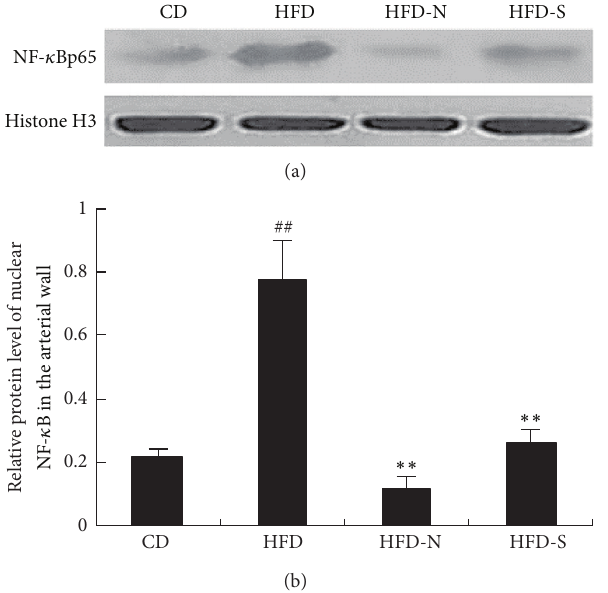
Figure 2: Niacin and simvastatin suppressed the expression of nuclearproteinNF- 𝜅 Bp65inthearterialwallofguineapigsfedhigh fat diet. The protein expression was analyzed by western blot and normalized to histone H3 level. (a) shows the representative image by western blot. (b) shows the IOD ratio of NF- 𝜅 B p65 to Histone H3. Data are presented as mean ± SD of at least three independent experiments. ## 𝑃 < 0.01 versus CD group; ∗∗ 𝑃 < 0.01 versus HFD group.